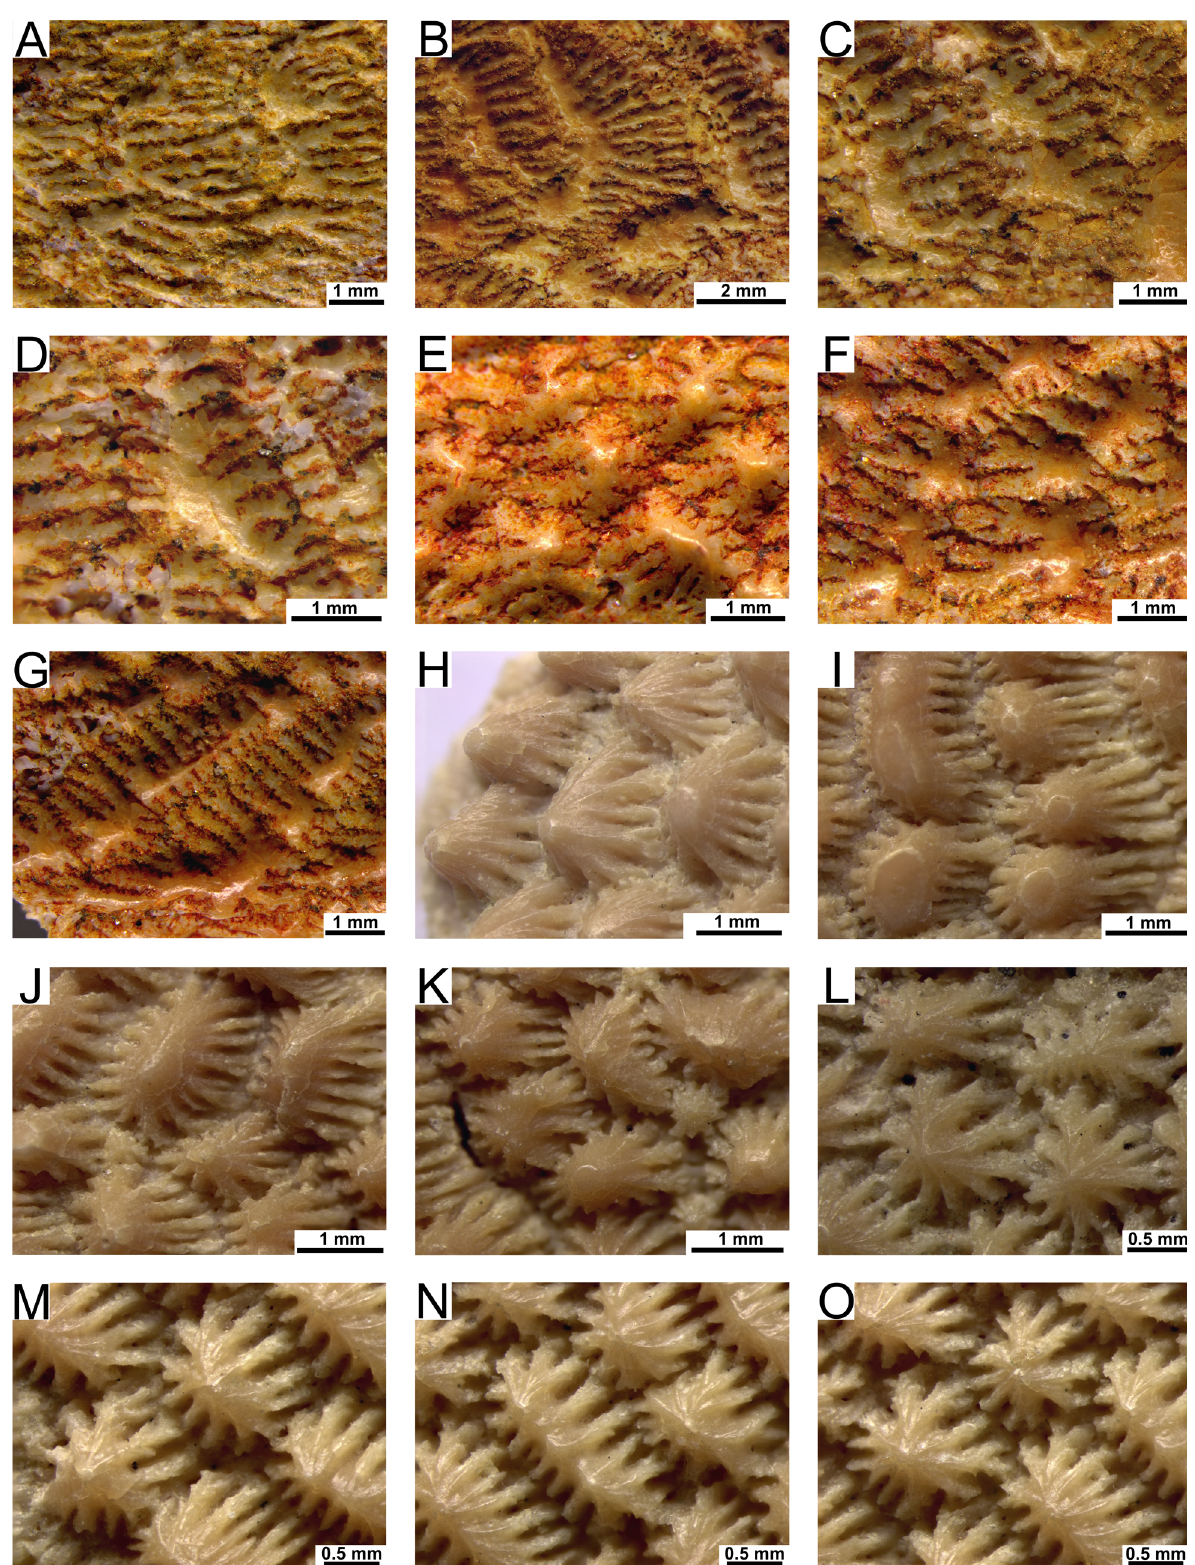
Fig. 4. Psammosteus ramosus sp. nov. Glinskiy, topographic variability of the ornament. Shots of ornamentation are shown in Fig. 3. A – G , PM SPU 80-2, holotype, fragment of left branchial plate, Andoma Hill, Russia. H – O , PM SPU 80-1, fragment of left branchial plate, Borschovo,